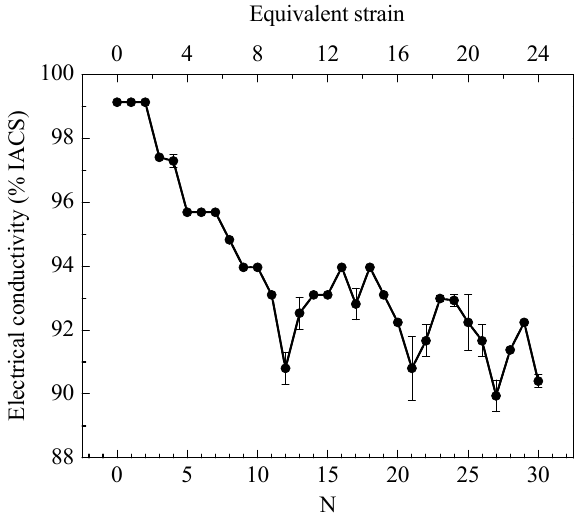
Figure 4. Electrical conductivity of ARBed Cu versus N and equivalent strain.